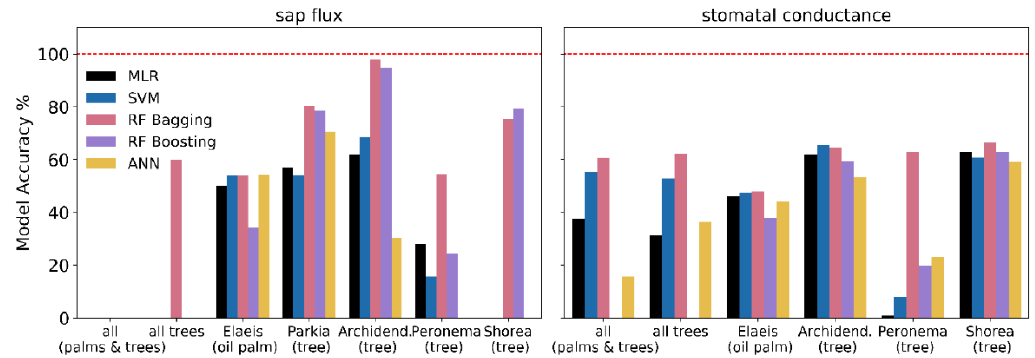
Figure 2. Model accuracy % comparing measured and predicted values of sap flux and stomatal conductance. Abbreviations: MLR—multiple linear regression; SVM—support vector machine; RF—random forest; ANN—artificial neural network.